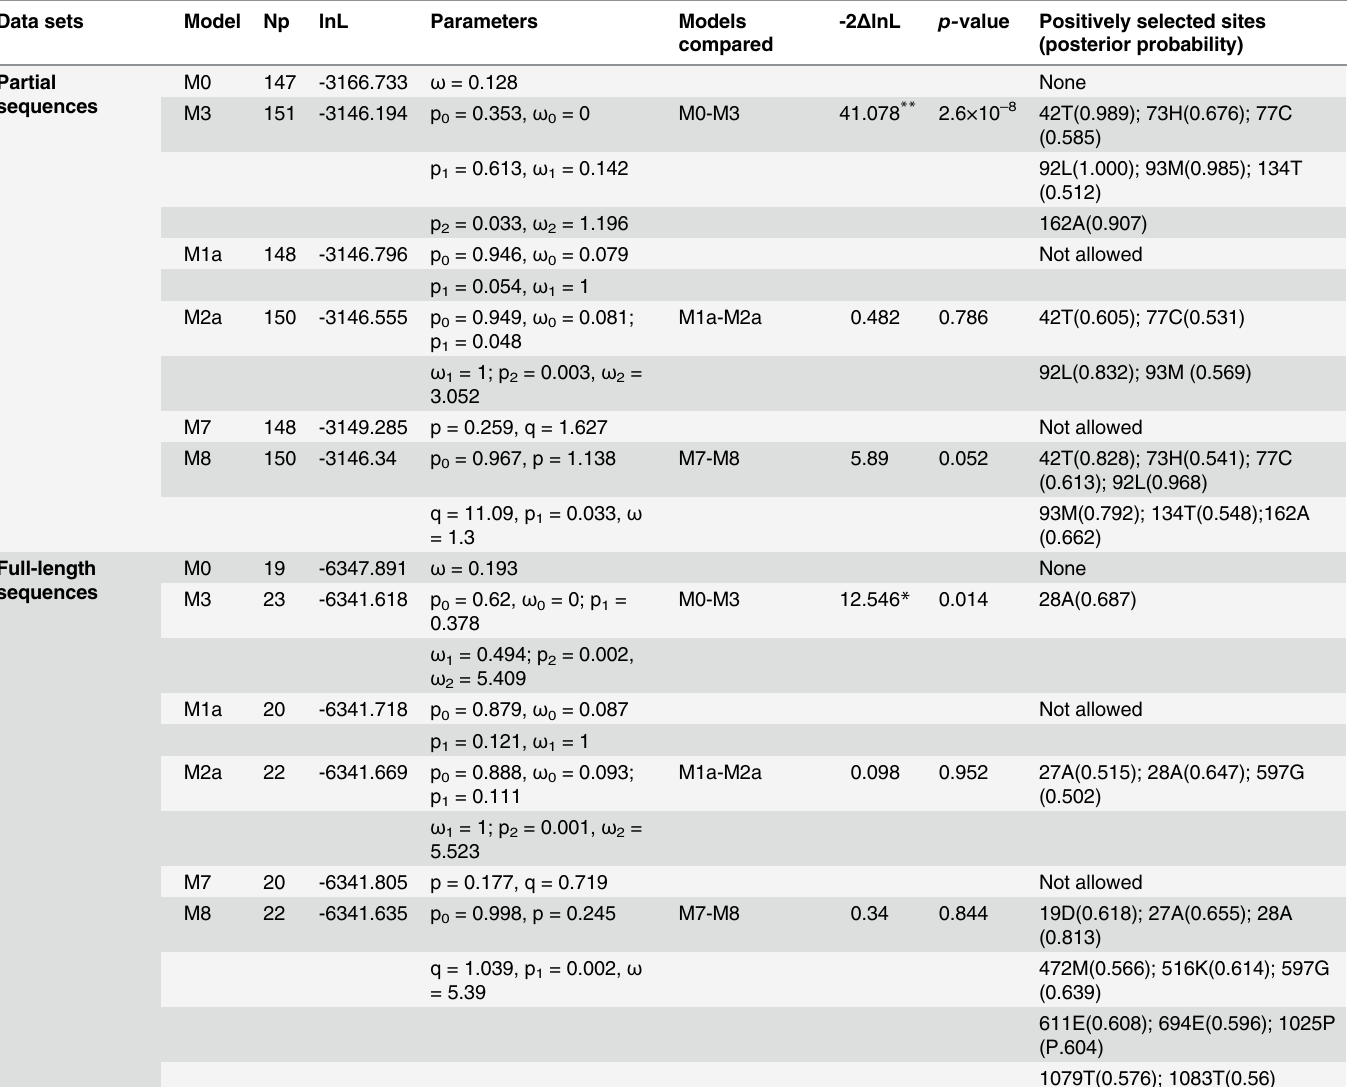
Table 1. Phylogenetic tests of positive selection for PHYE in Primulina using site models. Data